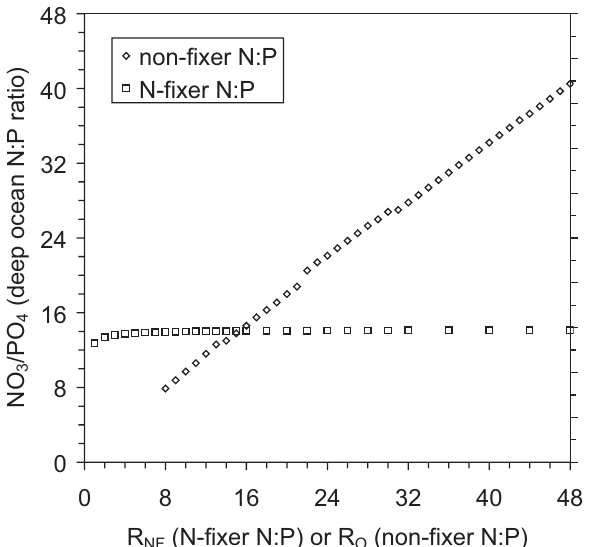
Fig. 7. Dependence of the deep ocean N:P ratio on the fraction of the surface ocean occupied by N 2 -fixers ( f A ) in the extended TT model, assuming an N:P Redfield ratio of 16 for both N 2 -fixers and other phytoplankton. Square symbols indicate a stable solution, di- amond symbols a limit cycle (oscillating solution). The oscillations are small, with a maximum amplitude of ∼ 0.75% (e.g. 13.3–13.5 for f A =0.3), and the diamonds are plotted at the mid point of the oscillations. The transition from a stable steady state to a limit cy- cle occurs in the range f A